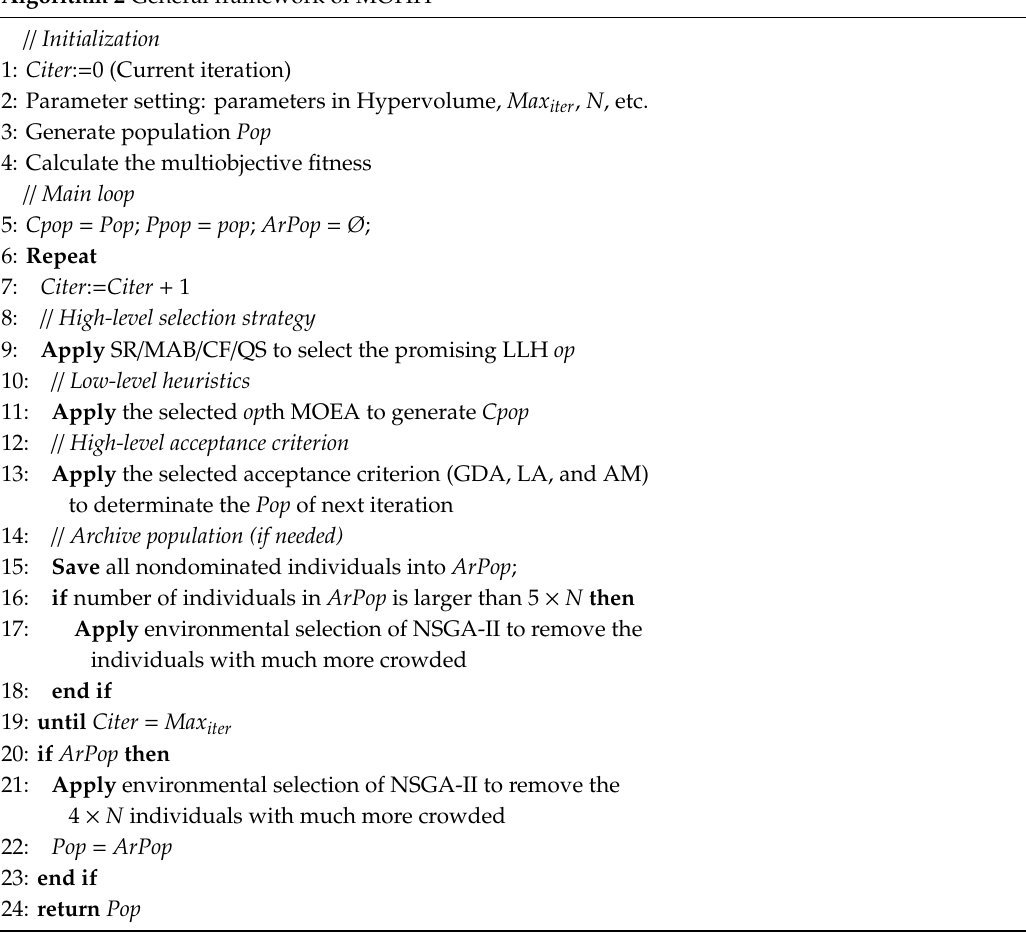
Algorithm 2 General framework of